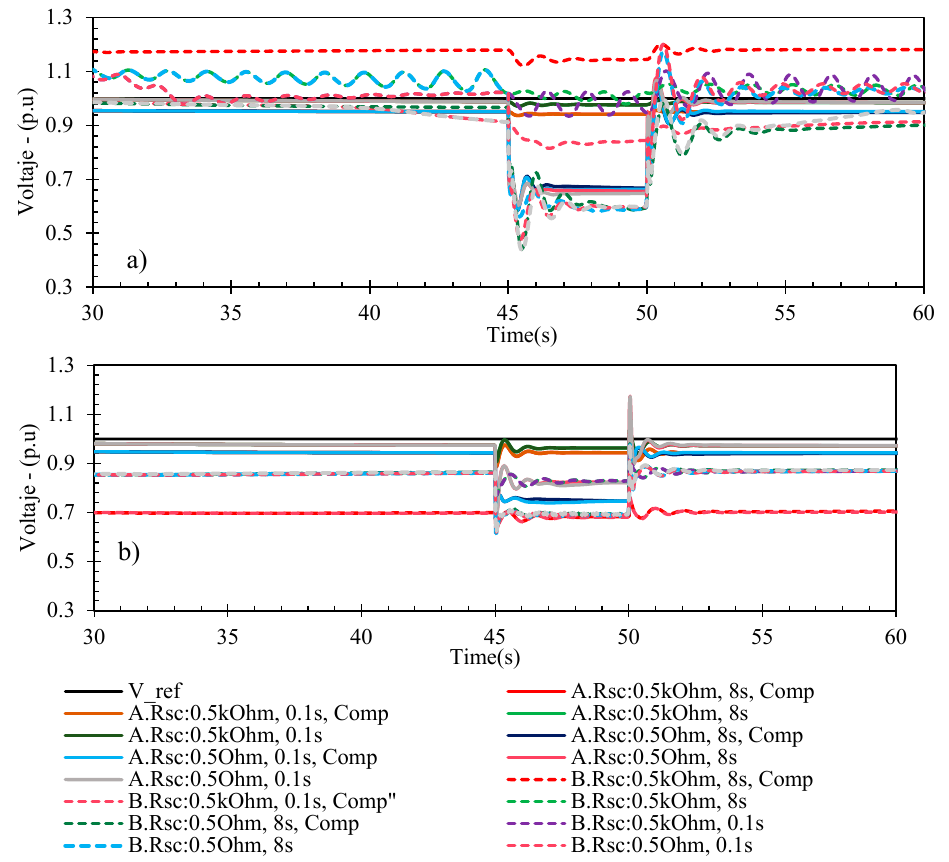
Figure 5. PCC voltage for cases A1 and B1 where ( a ) represents SCR = 10 and ( b ) represents SCR = 3. Finally, a harmonic analysis of the PCC voltage until the 15th harmonic was carried out, as shown in Figure 6. The dominant harmonic components were found to be the 2nd to the 4th. Figure 6 shows that correct sizing of the VSC filter permitted maintaining an acceptable level of grid power quality. The THD of the PCC voltage did not exceed the limit of 1%. The results of the simulations in Scenario B1 showed the 2nd, 3rd, 10th and 15th harmonics were more or less triple with respect to Scenario A1, and the harmonics from the 4th to the 9th were double.